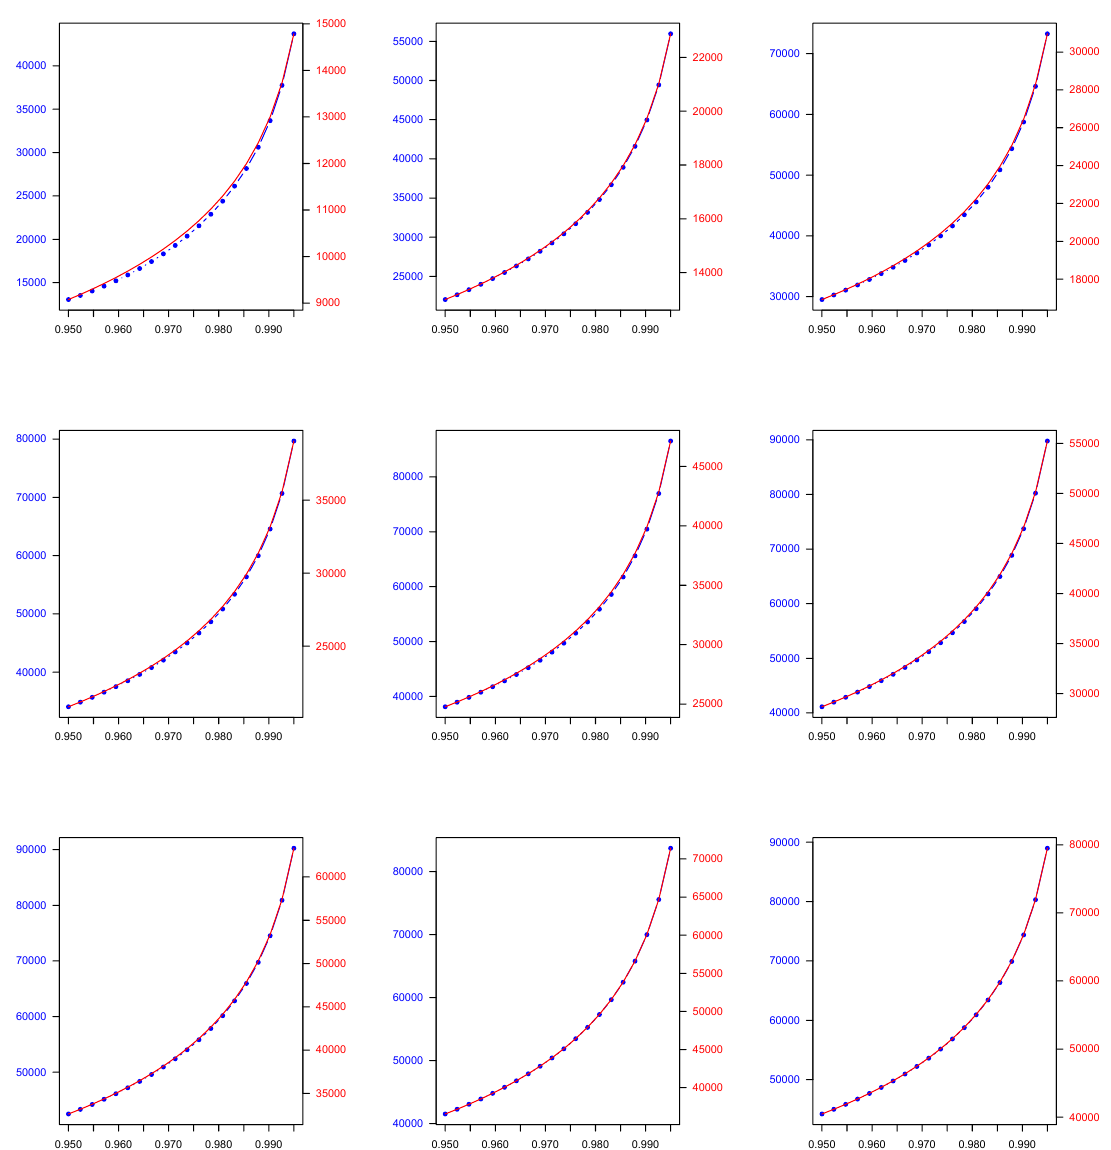
Figure 5. Two-Component (2C) Lognormal-Gamma finite mixture model-based (1 − α ) quantile Q mix . (blue colour) across all ( ˆ π 1 , ˆ π 2 ) combinations versus two-component (2C) Lognormal-Gamma weighted average-based (1 − α ) quantile Q w . a . (red colour) across all ( π 1 , π 2 ) combinations, where (1 − α ) takes values in the range of 0.950-0.995. Note that, due to a considerable discrepancy between Q mix . and Q w . a . values, each given plot has two different y axes-one for each quantile